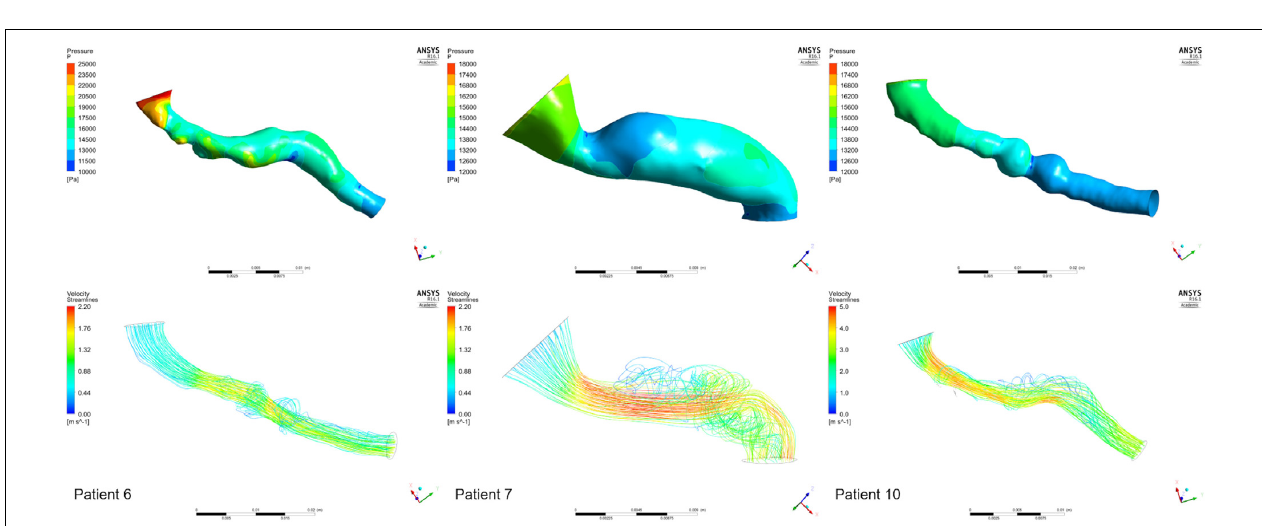
FIGURE 10 | Examples from the CFD analysis. Pressure distributions (top row) and velocity streamlines (bottom row) are presented for the stenoses of three patients: 6 (left column), 7 (middle column), 10 (Right RAS, right column).